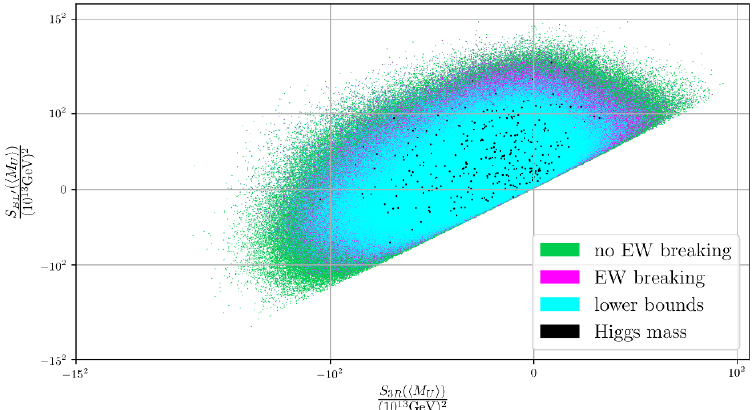
Figure 20. Results from generating 50 million sets of initial data where the B - L scale is chosen from a log-uniform distribution between 10 6 GeV and 10 14 GeV. We (cid:12)nd that 6,123,522 points break B - L but not electroweak symmetry, and 1,997,972 points break B - L and electroweak symmetry. Of the latter 1,040,259 points are consistent with current LHC bounds on sparticle searches. Finally, we have 305 points which satisfy all these conditions and are within the 2 (cid:27) window of the measured Higgs mass.